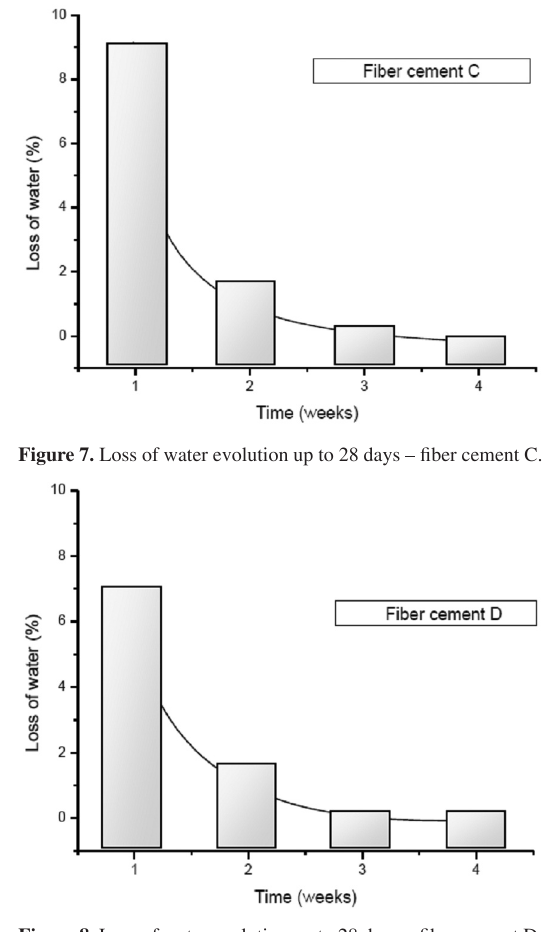
Figure 8. Loss of water evolution up to 28 days – fiber cement D.